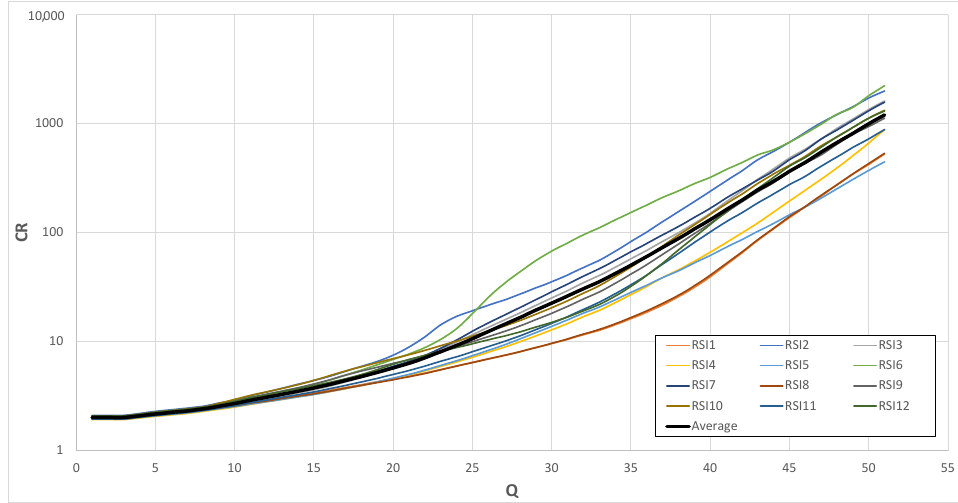
Figure 7. Curves of the CR dependence on the Q parameter for individual basic images (RSI #1–#12) and the obtained average curve in logarithmic scale. The pseudo-code illustrating the main idea of the method is provided in Algorithm